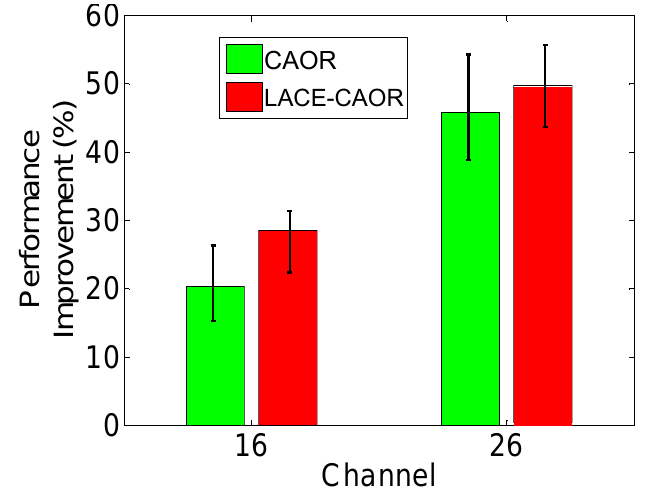
Figure 5. Delay performance evaluation with CAOR